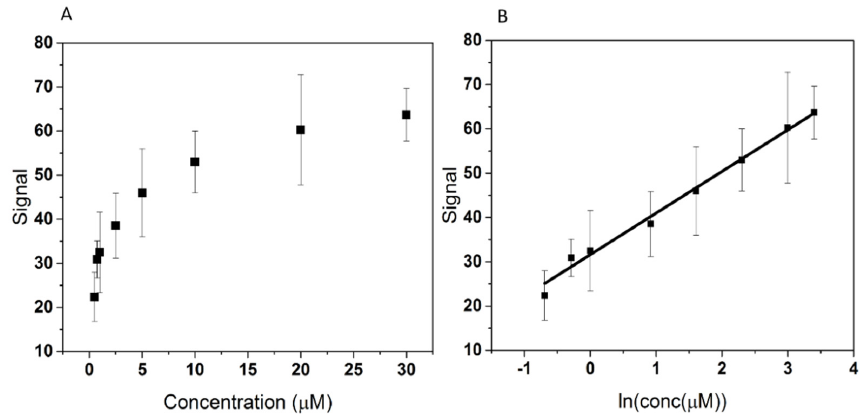
Figure 10. The correlation between the signal and the concentration of 3-O-C 12 -HSL ( A ), and linear fitting of the correlation between the signal and ln of the concentration of 3-O-C 12 -HSL ( B ). Table 4 presents the comparison of the analytical performance of the developed ap- tasensor with several other analytical methods. The aptasensor developed in this study presents the broadest dynamic range and an LOD that is low enough to allow the detec- tion of 3-O-C 12 -HSL in different biological samples of practical relevance. Even though the aptasensor described in this study has a higher LOD than the ones obtained using the other methods, it exhibits several advantages compared to the other methods, including easy and low-cost fabrication, a simple sensing process, and providing a proof-of-concept of an aptasensor for 3-O-C 12 -HSL detection in real biological and bacteriological samples. Table 4. Comparison of this aptasensor with other methods previously reported for 3-O-C 12 -HSL detection. Method